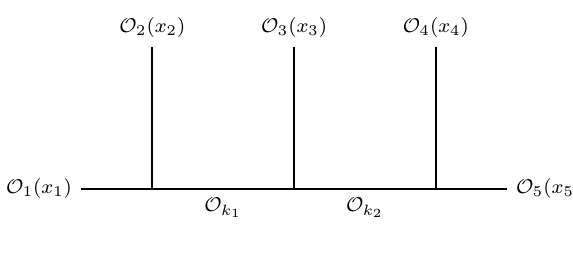
Figure 7 . 5-point conformal